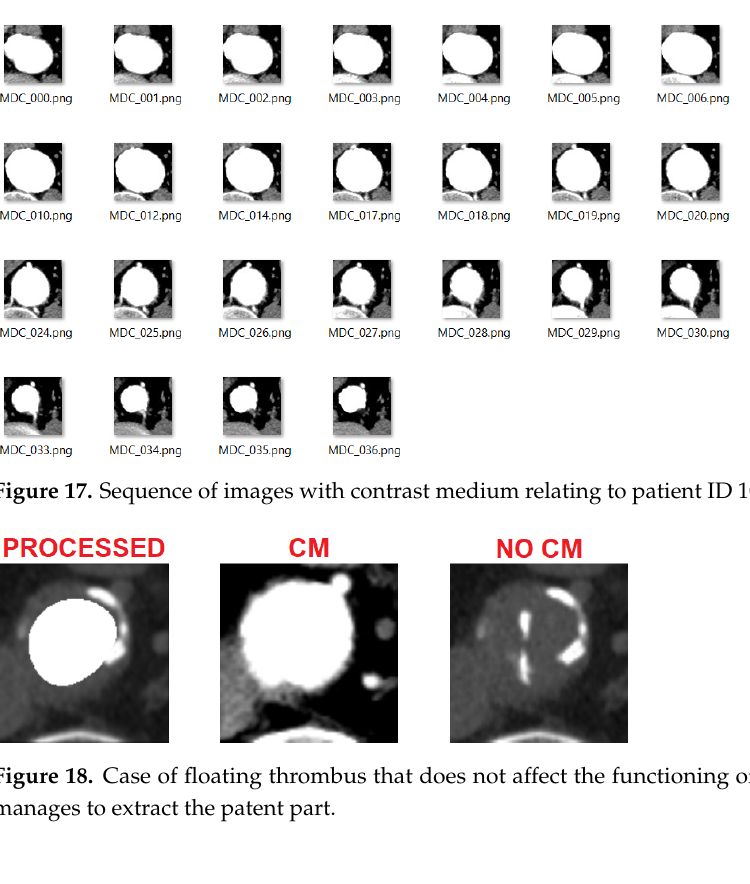
Figure 16. Case of underestimation of the extraction procedure.